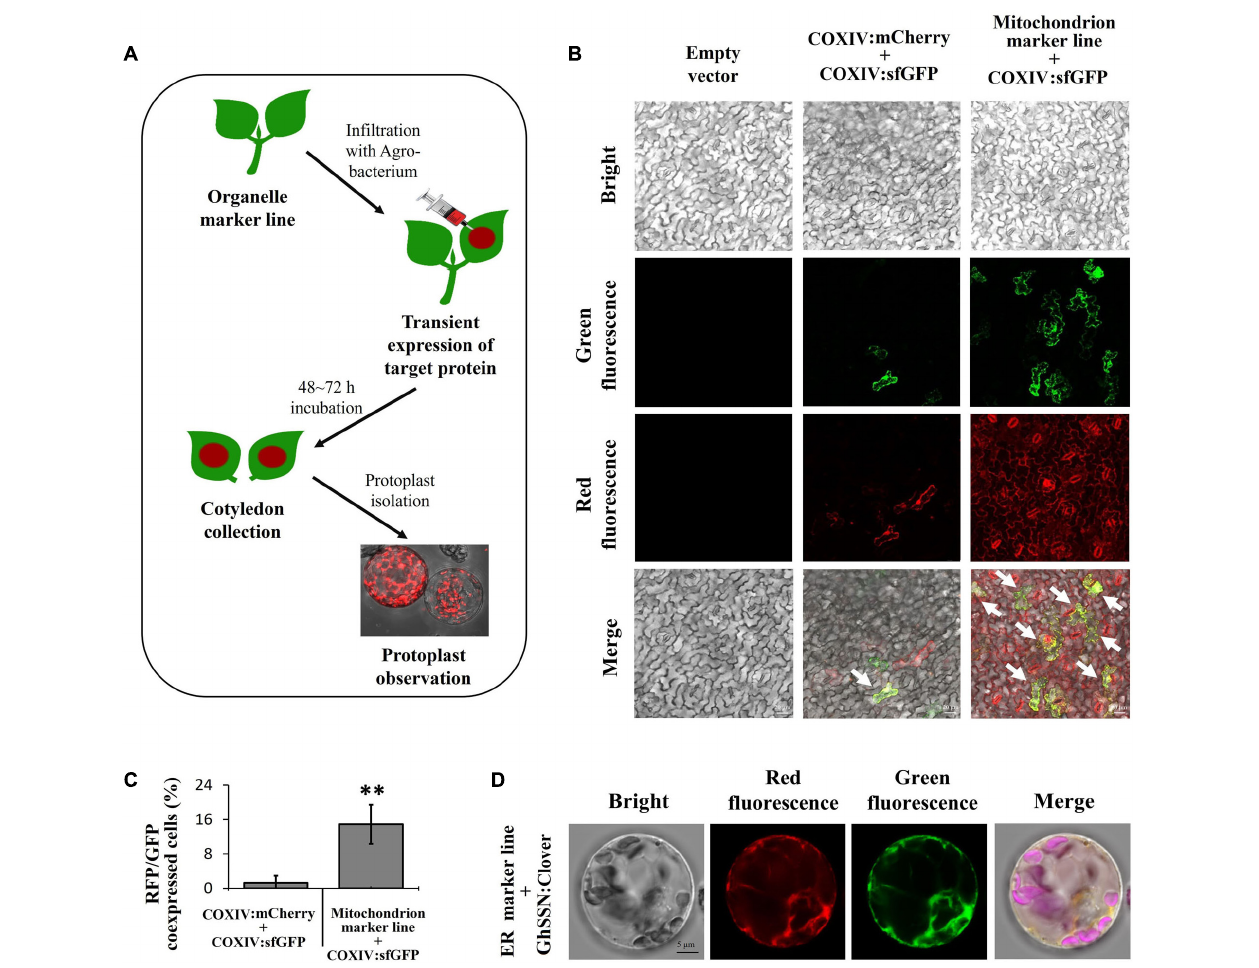
FIGURE 8 | Fast validation for the subcellular localization of target protein in cotton cells. (A) Diagram of the strategy for validation of protein localization in cotton cells using transgenic cotton organelle marker lines. (B) Evaluation of the co-expression efficiency. Co-infiltration of COXIV:sfGFP and COXIV:mCherry constructs into cotyledons of wild-type cotton (middle panel, control group); infiltration of the COXIV:sfGFP construct into cotyledons of a mitochondrion marker line constitutively expressing COXIV:mCherry (right panel, experiment group). The cells expressing both sfGFP and mCherry are indicated with white arrows; scale bar, 20 µ m. (C) The calculation of red and green fluorescent protein (RFP and GFP, respectively)-co-expressing cells in cotton cotyledons. n ≥ 5, ** P < 0.01, t -test. (D) Subcellular localization of GhSSN. The protoplast was isolated from cotyledons of a cotton endoplasmic reticulum (ER) marker line infiltrated with GhSSN: Clover; scale bar, 5 µ